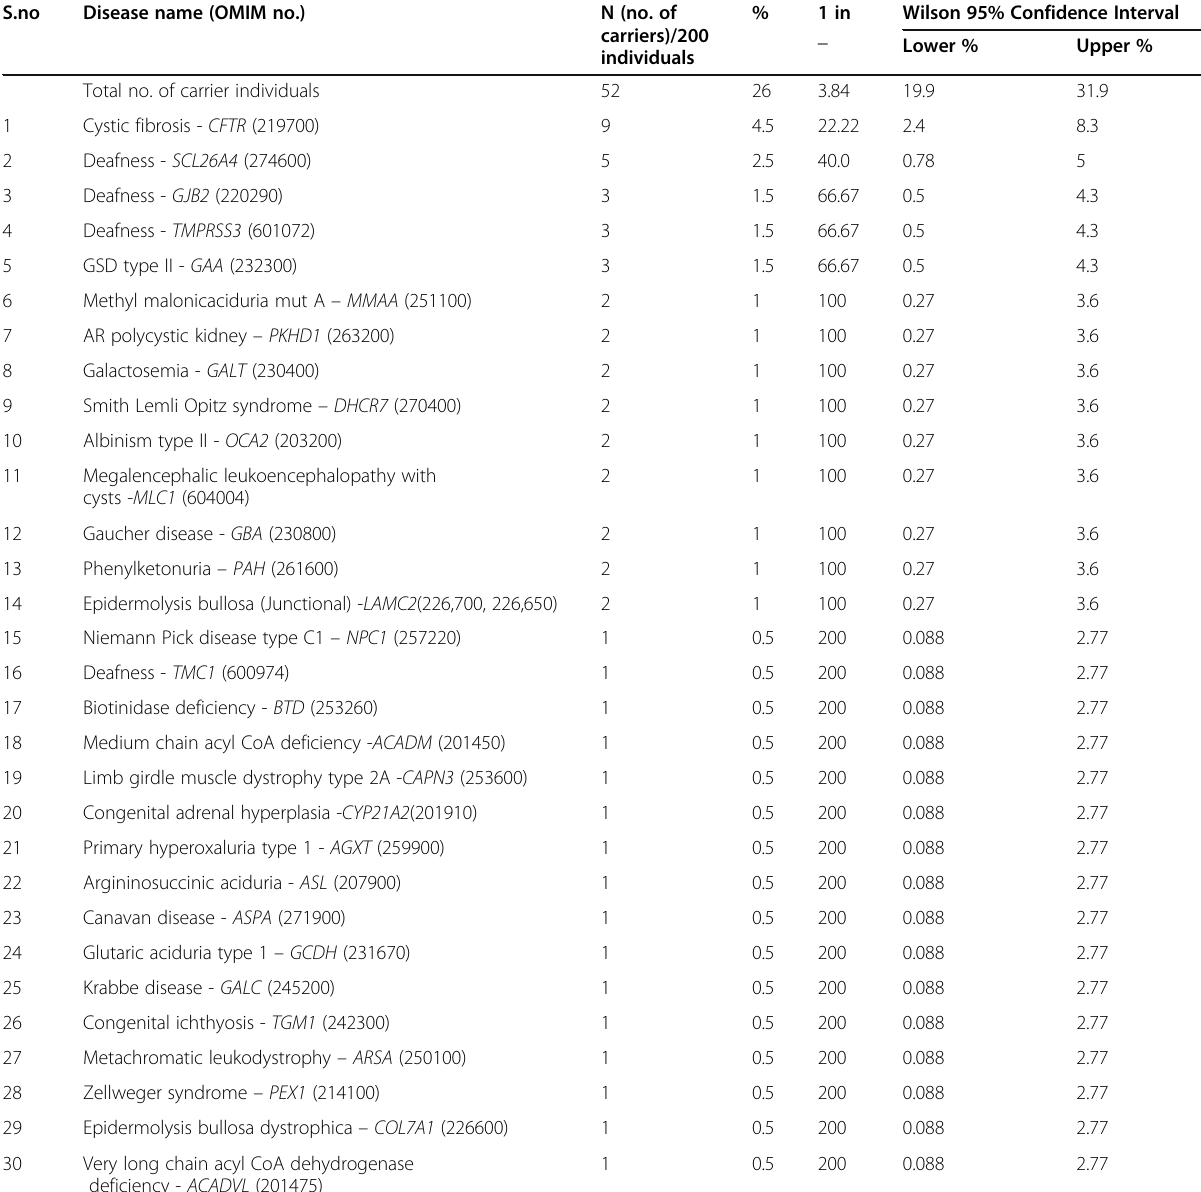
Table 2 Carrier frequency of the disorders screened S.no Disease name (OMIM